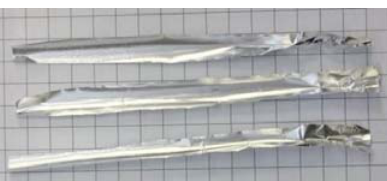
Figure 5. Appearance of TNT samples for working with a sample preparation module in the form of a heated tube.